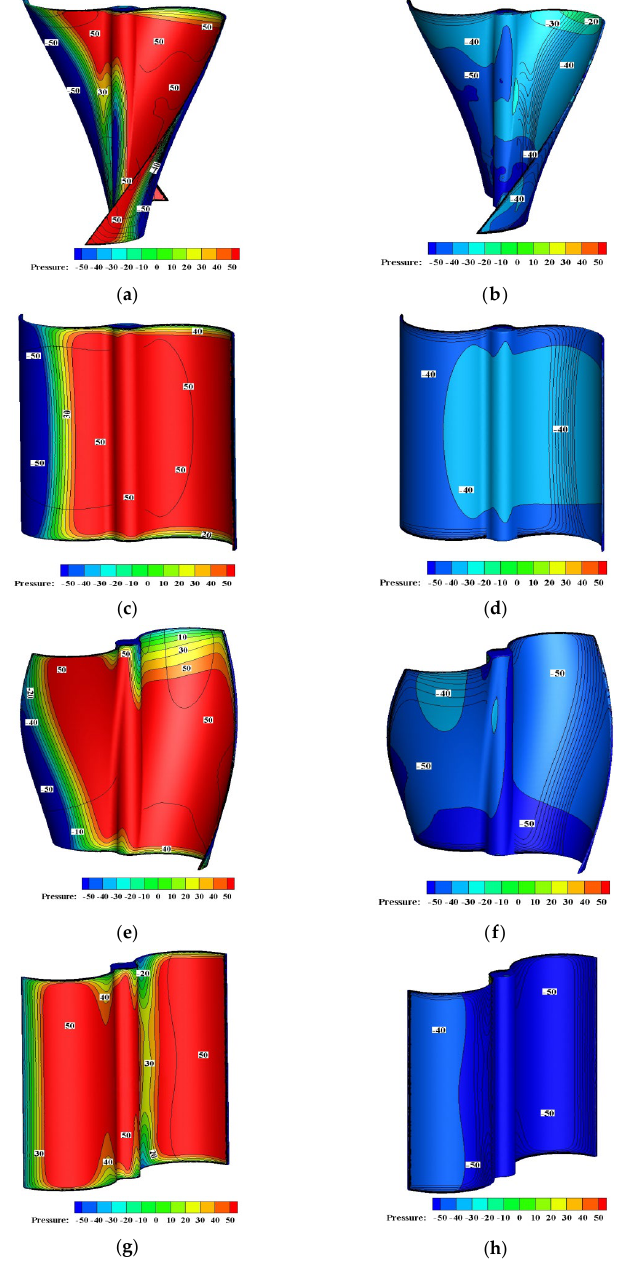
Figure 10. Pressure and streamlines nephograms of wind turbine. ( a ) upwind side of spiral wind turbine with azimuth of 60 ◦ . ( b ) leeward side of spiral wind turbine with azimuth of 60 ◦ . ( c ) upwind side of basic wind turbine with azimuth of 60 ◦ . ( d ) leeward side of basic wind turbine with azimuth of 60 ◦ . ( e ) upwind side of spiral wind turbine with azimuth of 120 ◦ . ( f ) leeward side of spiral wind turbine with azimuth of 120 ◦ . ( g ) upwind side of basic wind turbine with azimuth of 120 ◦ . ( h ) leeward side of basic wind turbine with azimuth of 120 ◦